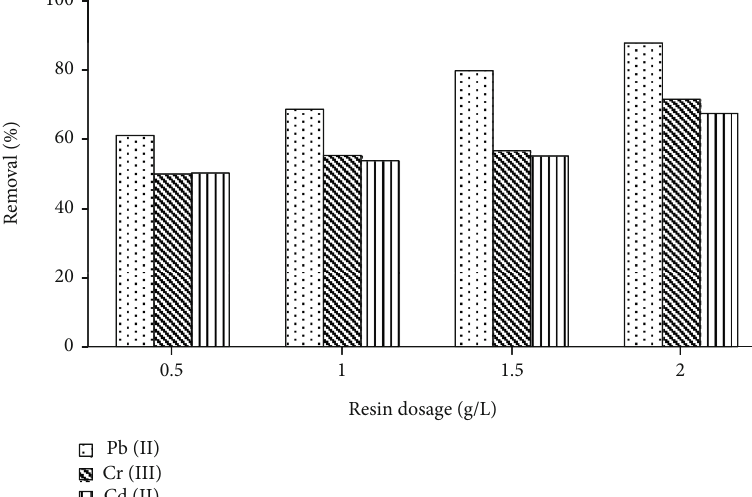
Figure 13: E ff ect of adsorbent dosage on adsorption of lead (II), Cr (III), and Cd (II); initial concentrations: 50mg/L; time: 60 min; solution: pH 5; and temperature: 25 °